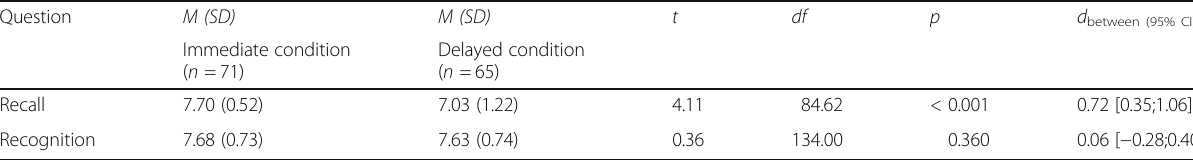
Table 3 Mean scores (SDs in parentheses) on the memory questionnaires (range 0-8) Question M (SD) M